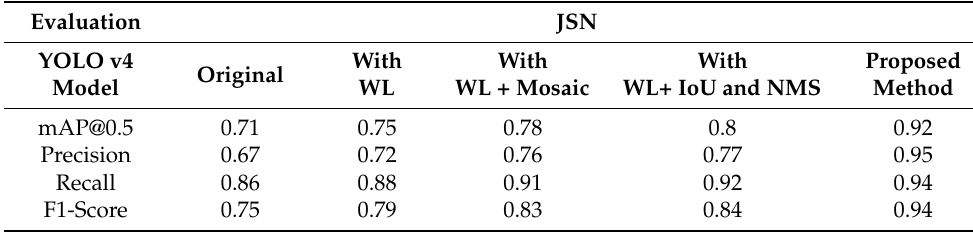
Table 5. Evaluation of research models YOLOv4 (608 ×